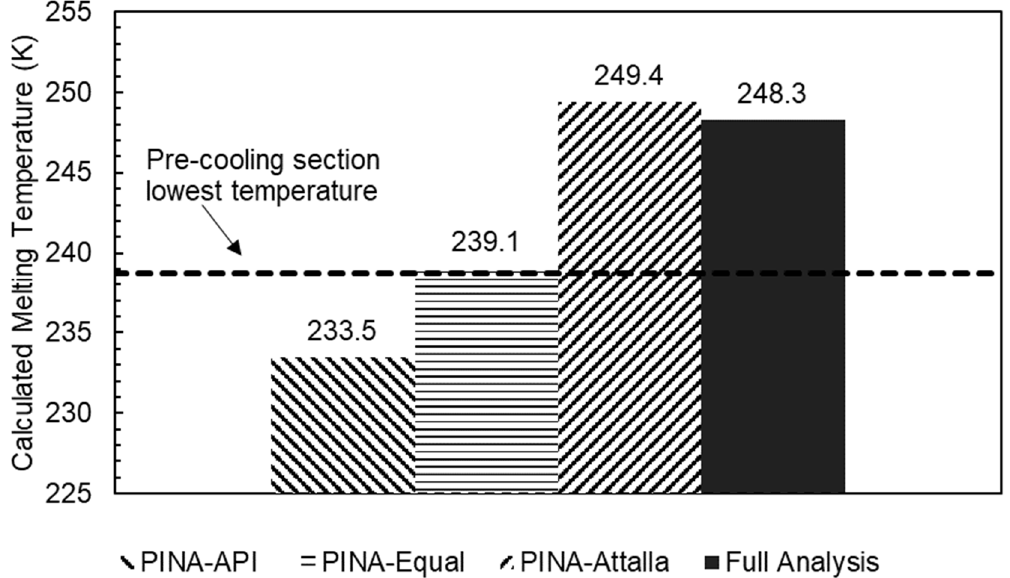
Figure 6. Comparison of the melting temperature calculated using various PINA freeze-out pre- diction methods at a pressure of 6.307 MPa (900 psig) with that based on the Full compositional characterization for the average gas sample.